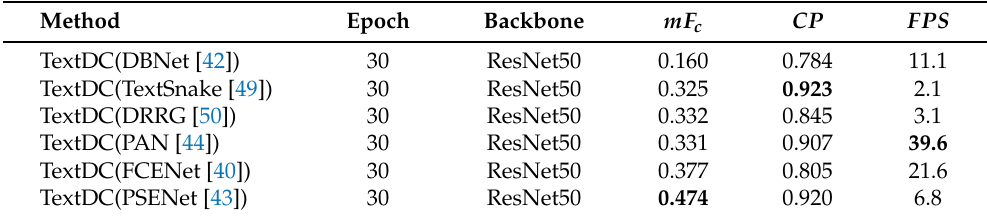
Table 4. Comparison of detection, classification, and speed of TextDC with state-of-the-art methods on the established Text3C dataset. Bold indicates the best